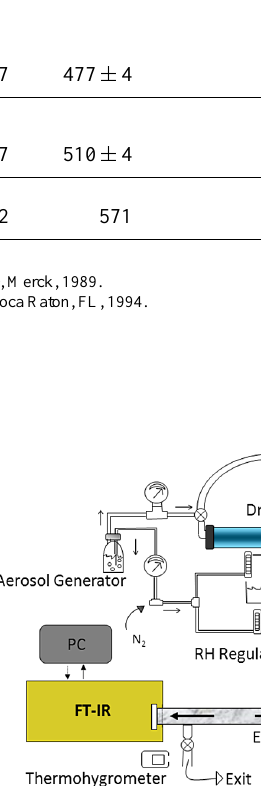
Figure 1. A diagram of the experimental setup. RH is measured by a thermo-hygrometer with the sensor placed at the exit of the aerosol flow cell. The heating cell where the organic acid sample is located can be heated by two independent resistors at two different temperatures: T 1 (75–100 ◦ C) in the central part of the tube and T 2 (60–90 ◦ C) at the exit